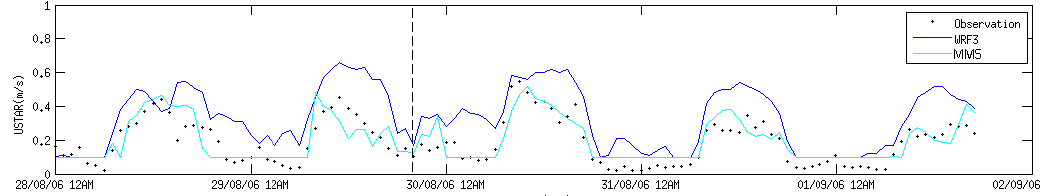
Figure 6. Time series for friction